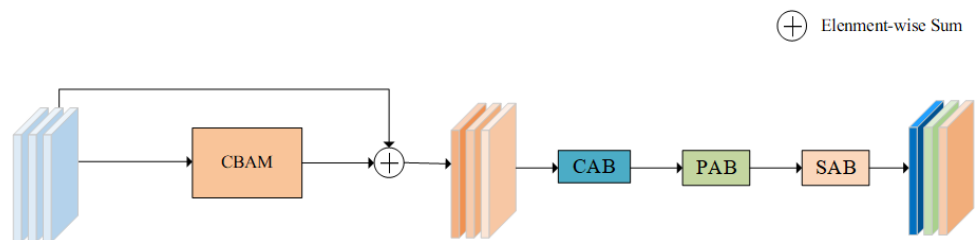
Figure 2. The structure of combined attention